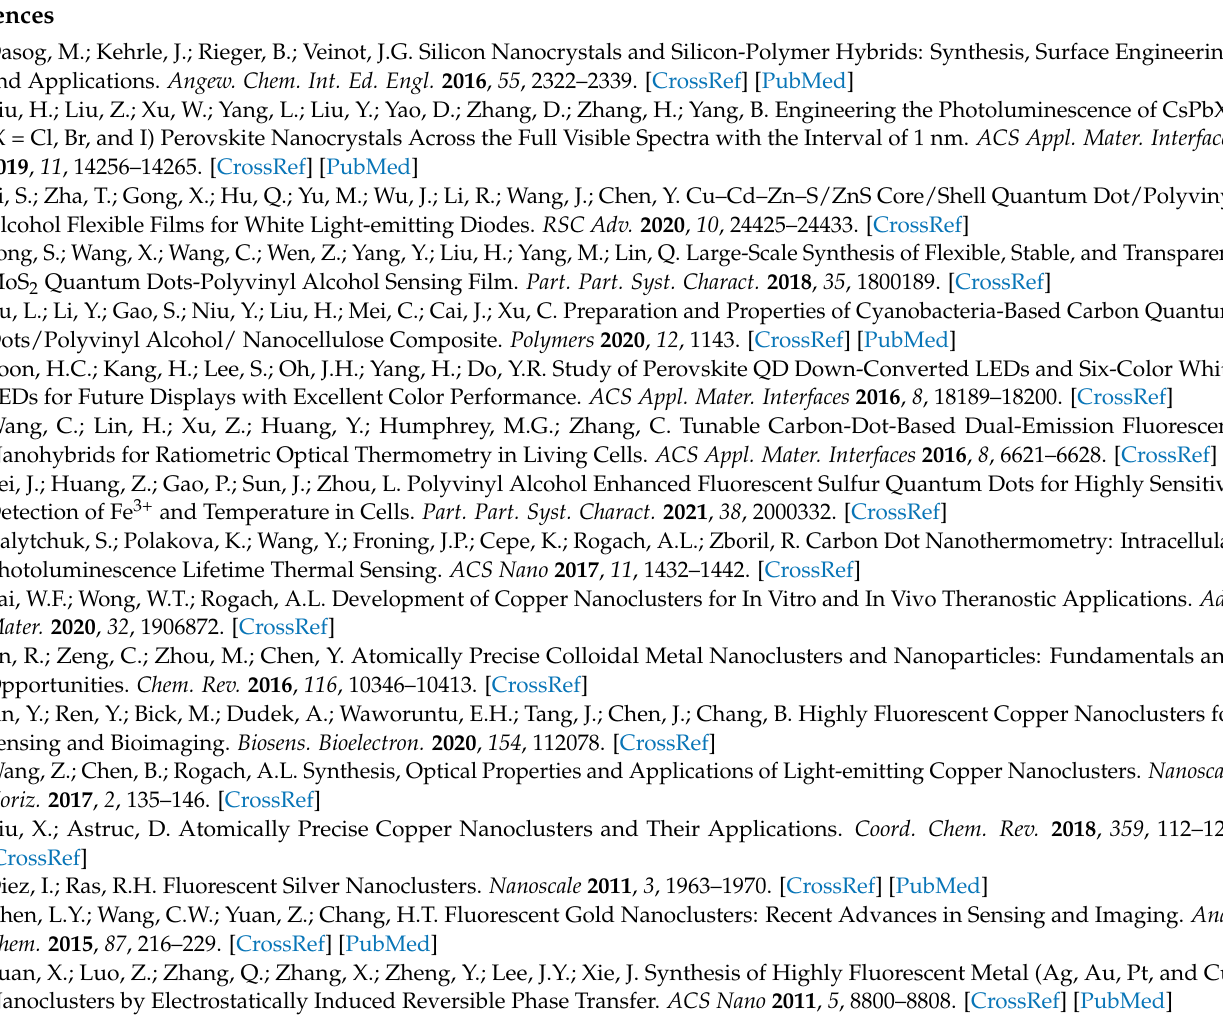
NCs/PVA film; Figure S5: XRD patterns of PVA film, Cu-MMI NCs/PVA film, Au-ATT NCs/PVA film, and Au-BSA NCs/PVA film; Figure S6: FTIR spectra of PVA, Cu-MMI NCs/PVA, Au-ATT NCs/PVA, and Au-BSA NCs/PVA composite films; Figure S7: The linear regression curves of the PL emission intensity of (a) Cu-MMI NCs/PVA, (b) Au-ATT NCs/PVA, and (c) Au-BSA NCs/PVA composite films versus the weight content of MNCs; Figure S8: PL decay curves of the MNCs/PVA composite films, which are detected under 365 nm excitation. (a) Cu-MMI NCs, (b) Au-ATT NCs, and (c) Au-BSA NCs. Table S3: Photophysical data of MNCs and MNCs/PVA composite films. Figure S9: The structure illustration of a remote-type LED; Figure S10: PL emission spectra of WLEDs based on the triple composite films with different arrangement of Cu-MMI NCs/PVA, Au-ATT NCs/PVA, and Au-BSA NCs/PVA films, where B represents blue, G represents green and R represents red. From bottom up: (a) B-G-R, (b) B-R-G, (c) G-R-B, (d) G-B-R and (e) R-B-G; Table S4: Index parameters of WLEDs based on the triple composite films with different arrangement of Cu-MMI NCs/PVA, Au-ATT NCs/PVA, and Au-BSA NCs/PVA films from the bottom